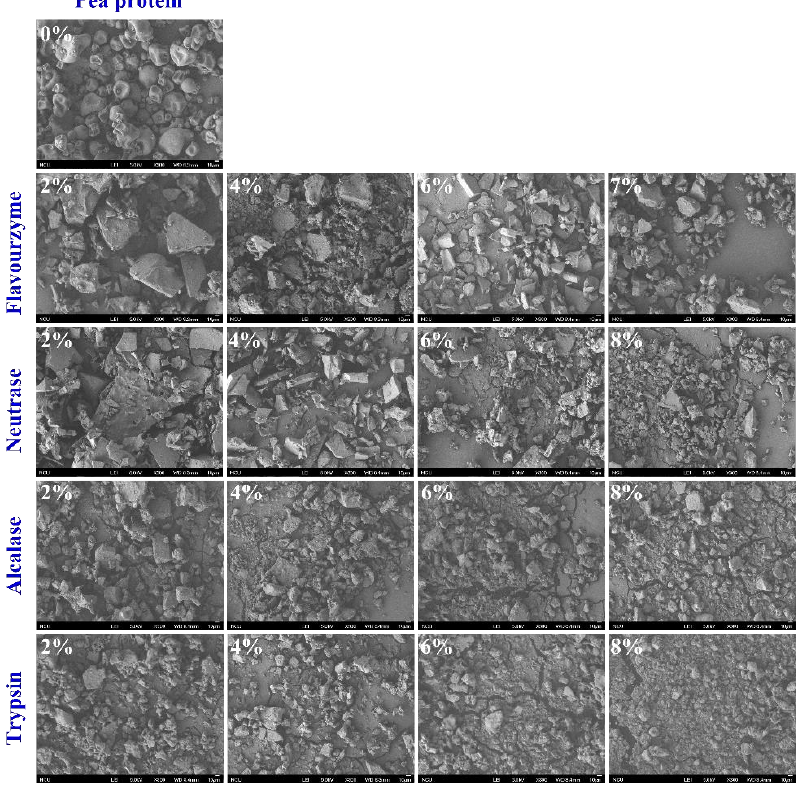
Figure 4. Morphology of PP and PP with different DH samples.